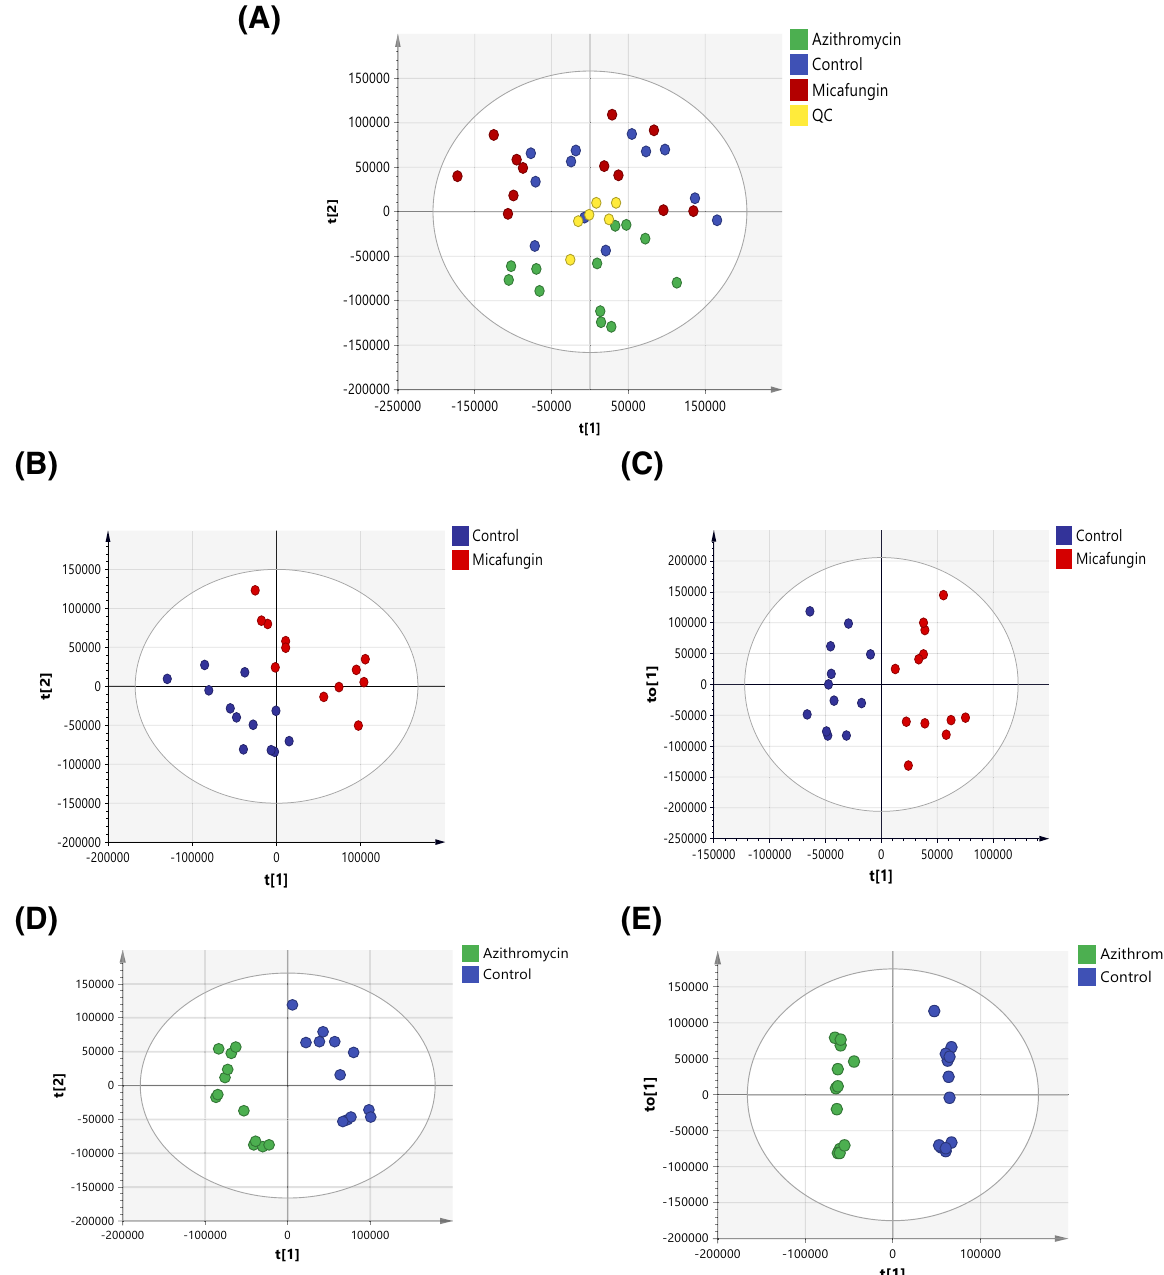
Fig. 3 Scores plots of P. aeruginosa samples after 24 h treatment with azithromycin (green circles) or micafungin (red circles) along with control without any treatment (blue circles). A PCA with quality control samples (QC, yellow points, n 6), R 2 X 0.653, Q 2 0.325, n 12. B PLS‑DA = = = = (R 2 X 0.531, R 2 Y 0.985, Q 2 0.746, n 12) and C OPLS‑DA scores plots (R 2 X 0.407, R 2 Y 0.859, Q 2 0.455, n 12). D PLS‑DA (R 2 X 0.604, = = = = = = = = = R 2 Y 0.992, Q 2 0.947) ( E ) and OPLS‑DA (R 2 X 0.604, R 2 Y 0.992, Q 2 = = = = =